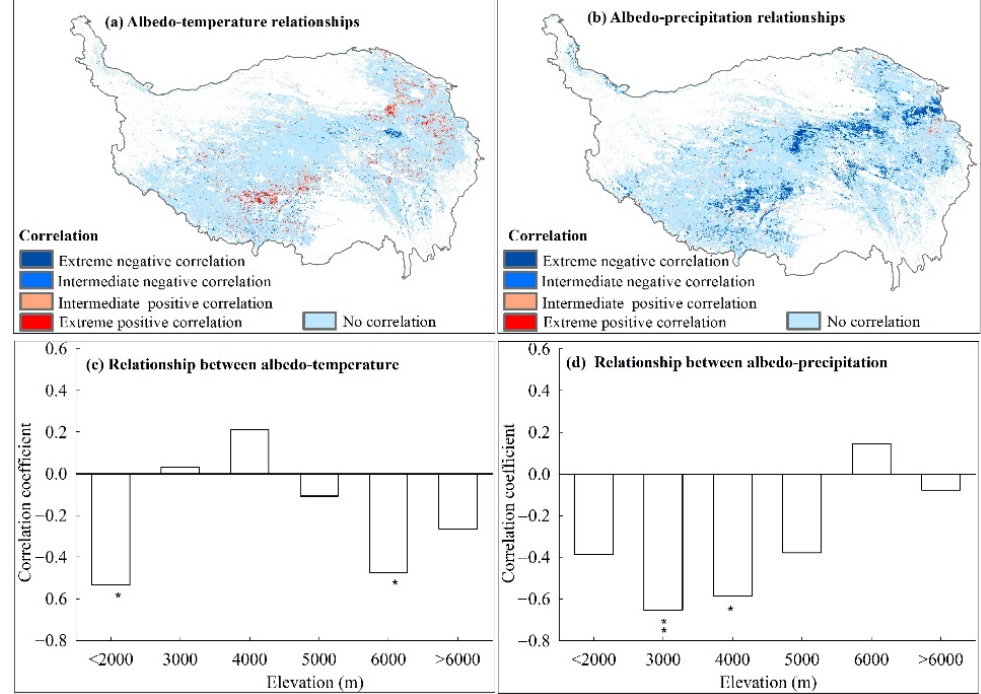
significantly positively affected areas were 19.69 × 10 3 km 2 (1.42%), only a few patches showed extremely positive correlations (4.49 × 10 3 km 2 , or 0.32%) or intermediate positive correlations (15.20 × 10 3 km 2 , or 1.10%).